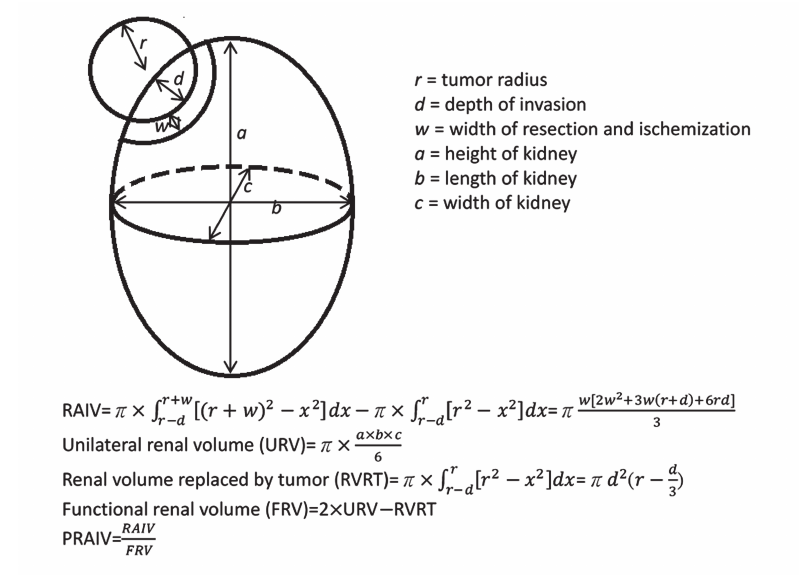
Figure 1 - Illustration of geometric renal tumor model and calculation process of RAIV and